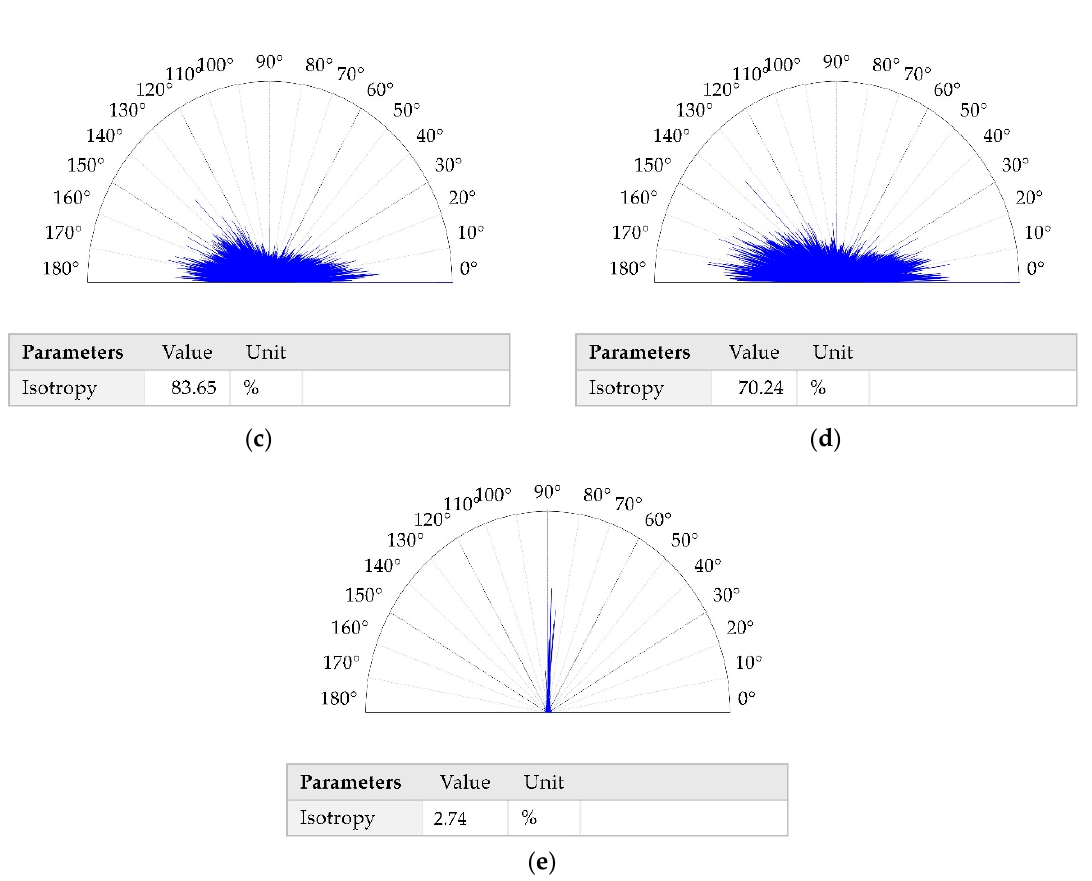
Figure 4. Directionality plots of disc surfaces after burnishing with a pressure (P) of 10 MPa ( a ), 20 MPa ( b ), 30 MPa ( c ), 40 MPa ( d ) and after milling ( e ).